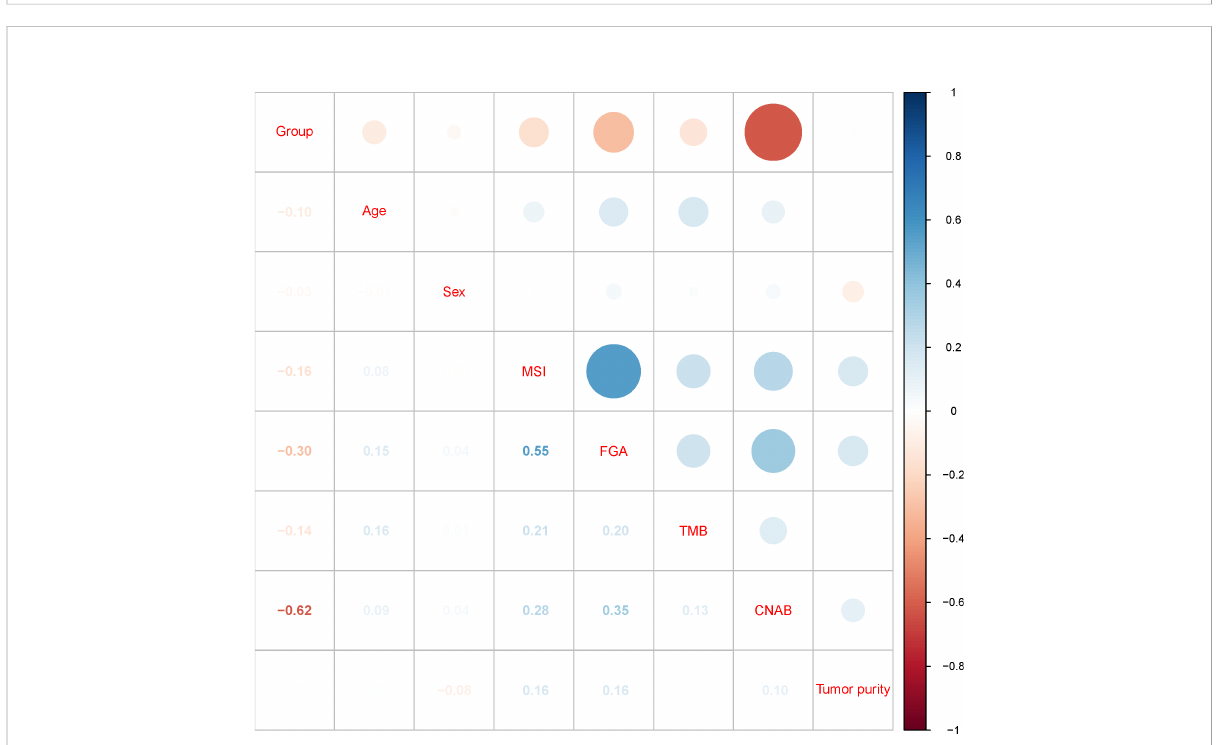
FIGURE 3 Correlation matrix of subgroups and clinicopathological characteristics. MSI, microsatellite instability; FGA, fraction genome altered; TMB, tumor mutational burden; CNAB, copy number alteration